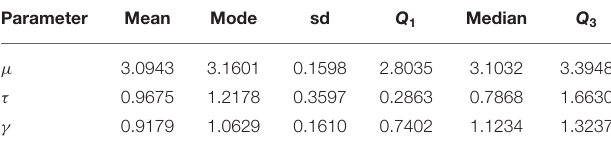
TABLE 4 | Bayes estimates of parameters based on scenario 4 with prior parameters µ 0